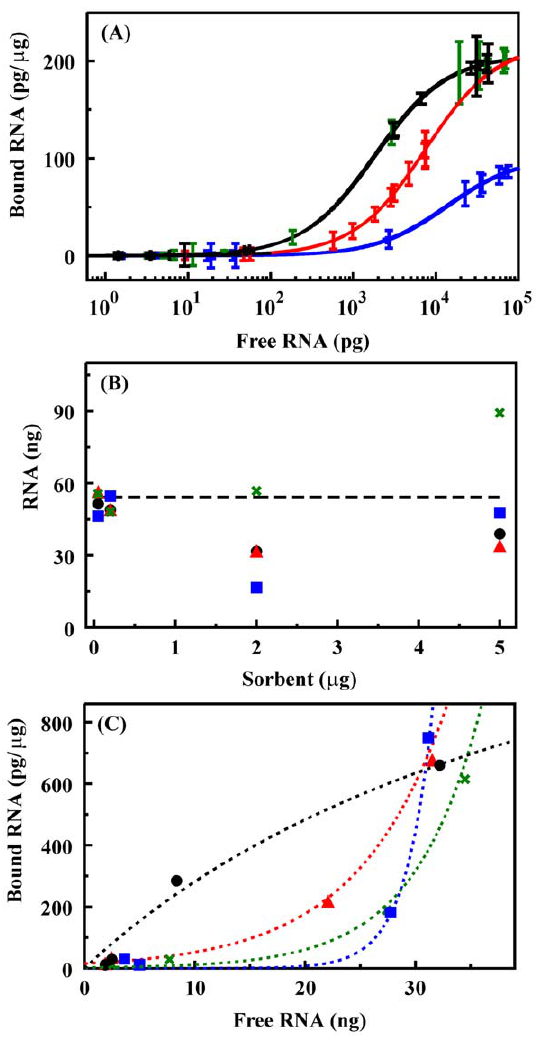
Figure 3. Binding of RNA by silicate materials. A. Binding isotherms for NS (black line, black symbols), NS-T (black line, green symbols), NS-G (blue), and NS-B (red) determined based on results of RT-PCR. Error bars are the standard deviation in the measurements. B. Comparison of initial RNA concentration to that recovered based on the fluorescence intensities of the supernatant and the solid components of the experiment: applied (dashed line); NS (black), NS-T (green), NS-G (blue), NS-B (red). C. Binding isotherm based on fluorescence intensity of the supernatant: NS (black), NS-T (green), NS-G (blue), NS-B (open circle). Lines are provided to indicate trends and are not representative of fits for this data.